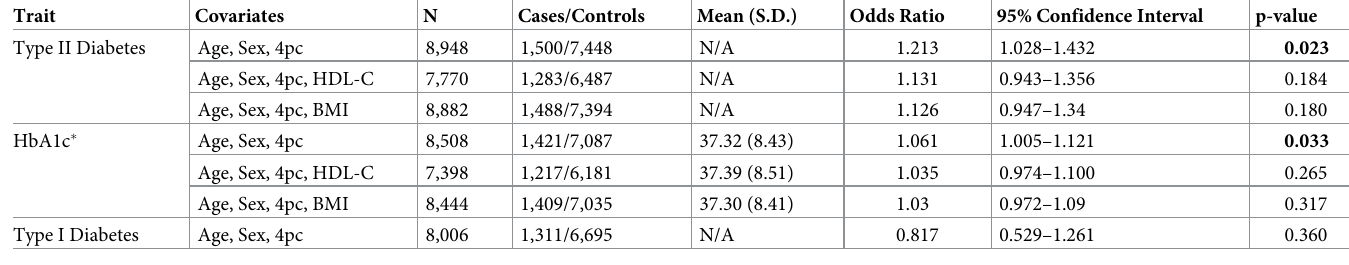
Table 5. Effect of diabetes and